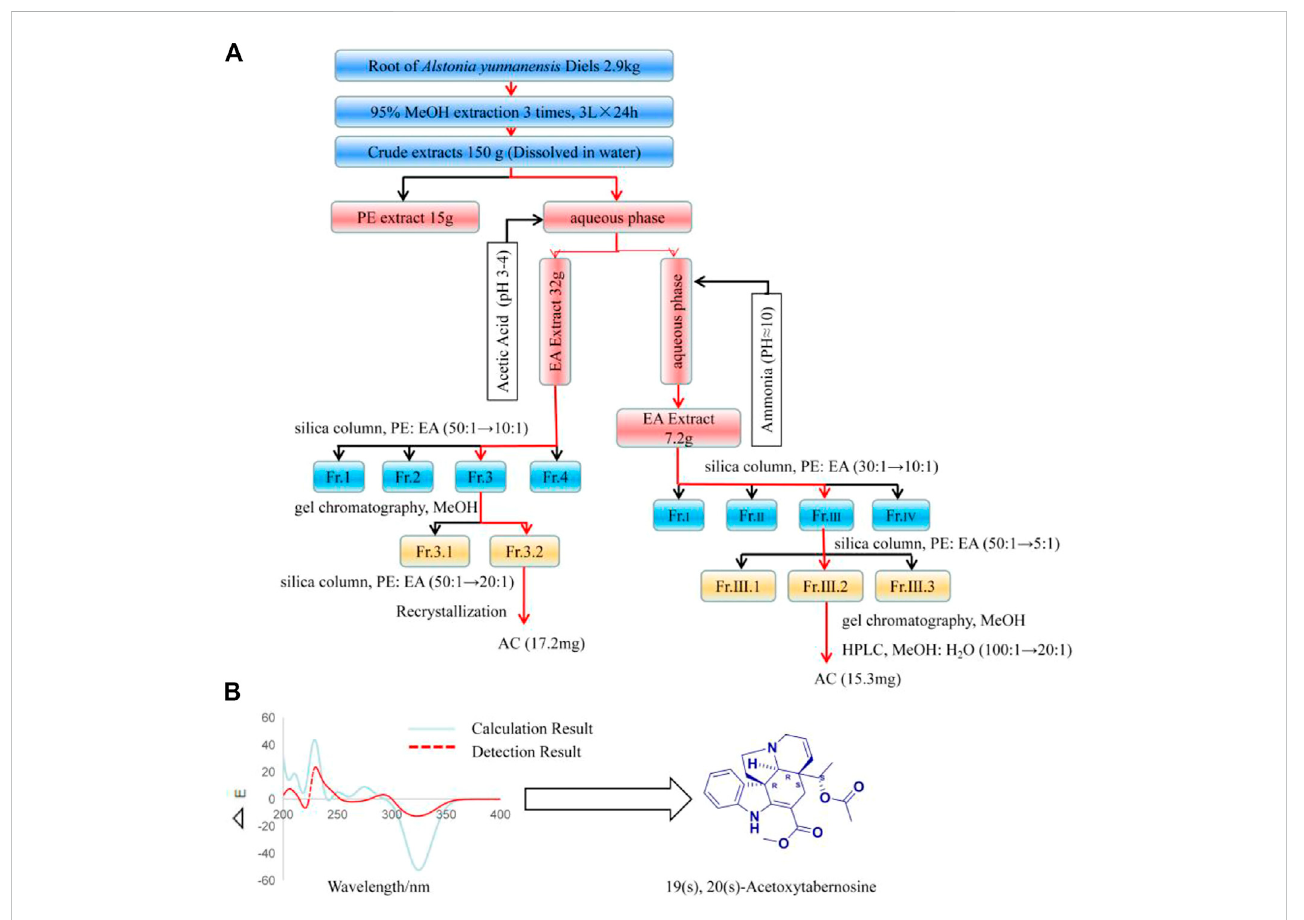
AC isolated from the Alstonia yunnanensis Diels root. (A) The extraction and isolation process of AC. (B) Experimental ECD spectra of AC, and the absolute con fi guration is 19(s), 20(s)